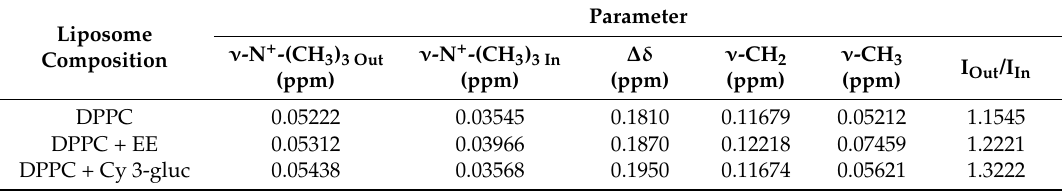
Table 3. Parameters of 1 H-NMR spectra at temperature 325 K of DPPC liposomes and DPPC liposomes with addition of elderberry extract (EE, ( v / v 400:1), and DPPC liposomes with addition of cyanidin 3- O -glucoside (Cy 3-gluc, mol/mol